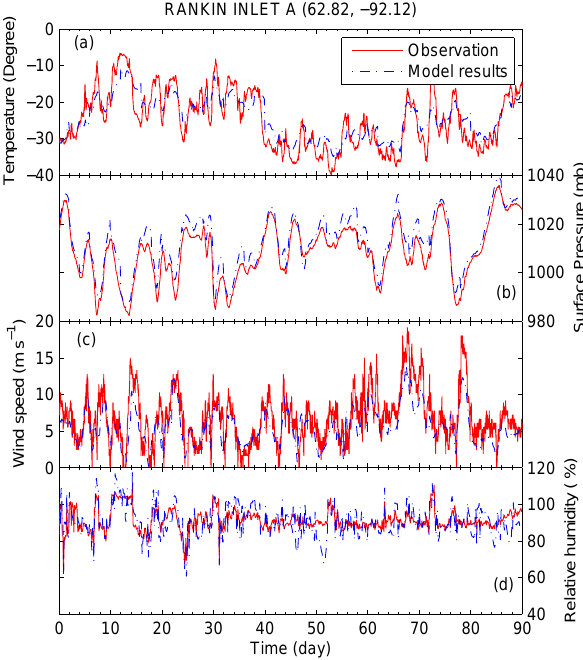
Fig. 5. Same as Fig. 4, but for Rankin Inlet (62.82 ◦ N, 92.12 ◦ W). sponds to the smallest wind threshold for the initiation of blowing snow according to the empirical relation proposed by Li and Pomeroy (1997). They noted that if the surface temperature is too cold, cohesion associated with strength- ening elastic and frictional forces reduces the wind capacity to displace snow from the surface and a higher wind thresh- old is required. On the other hand, if the temperature is too warm, some of the melted snow water will increase the cohe- sion among the particles, and a high wind threshold is needed to eject snow particles.